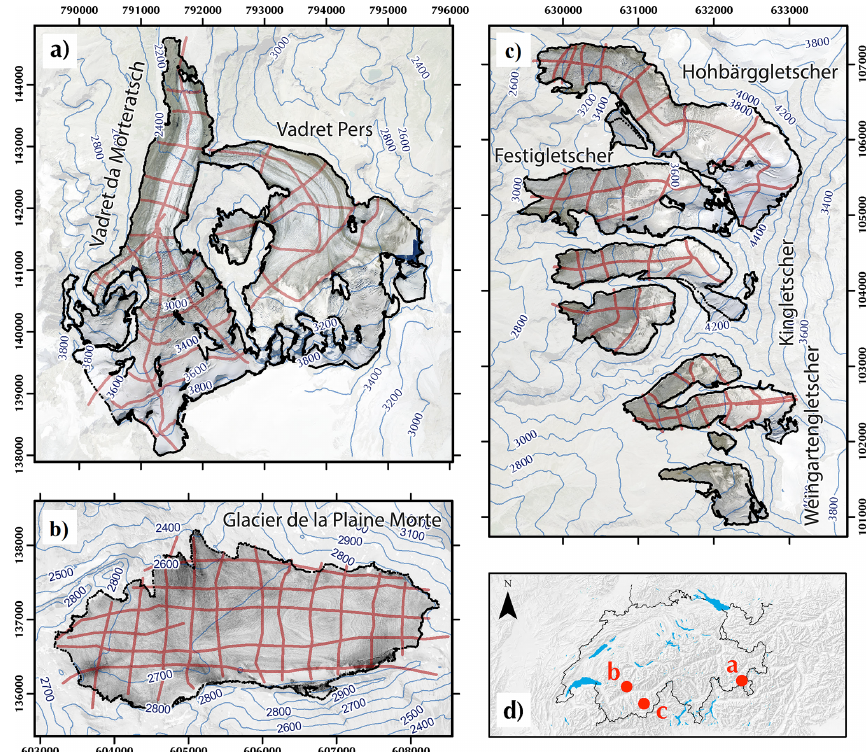
Figure 1. Orthoimages and surface topography isolines of the glaciers investigated: (a) Vadret da Morteratsch, (b) Glacier de la Plaine Morte and (c) the Dom region. The map of Switzerland in panel (d) indicates the locations of the glaciers. GPR profiles acquires are shown in red. Orthophotos © 2017 swisstopo (JD100042). Coordinate system: